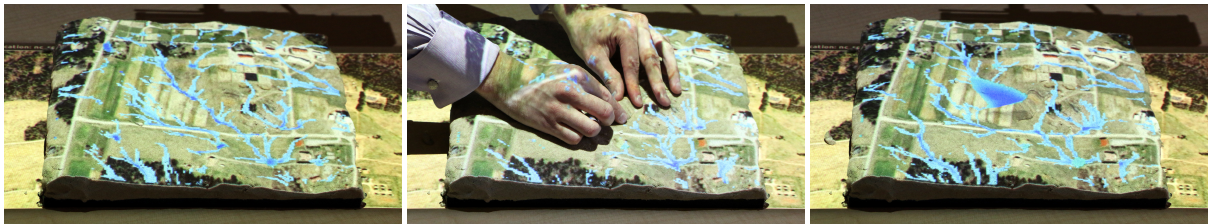
Figure 1: Tangibly modeling the flow of water with Tangible Landscape